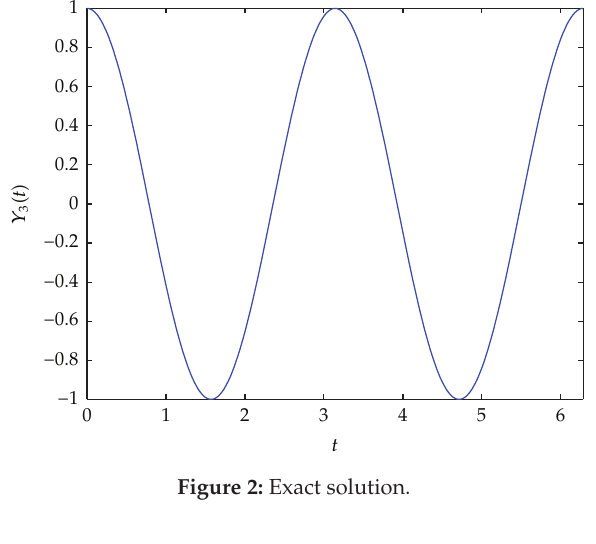
Figure 2: Exact solution.